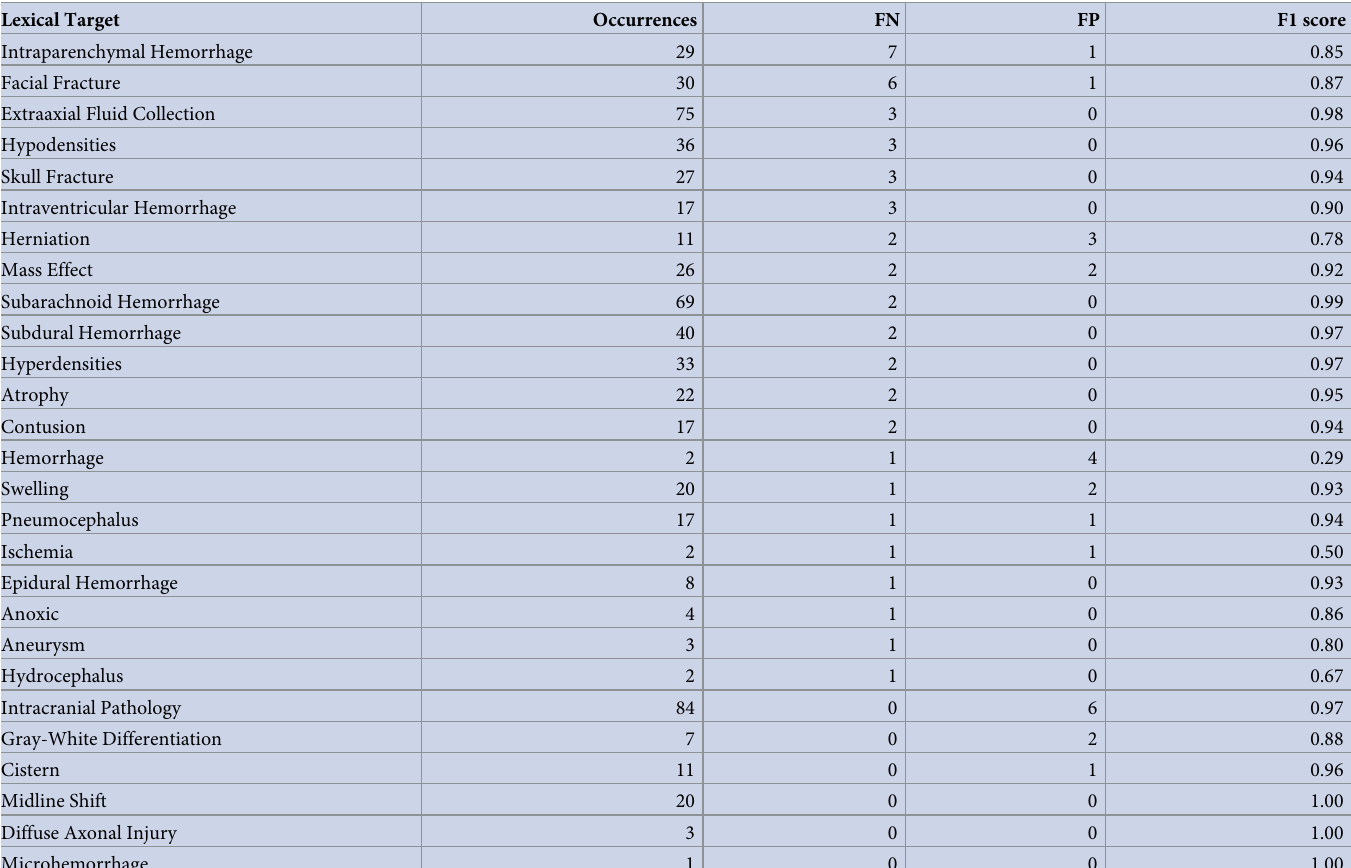
Table 4. tbiExtractor lexical target